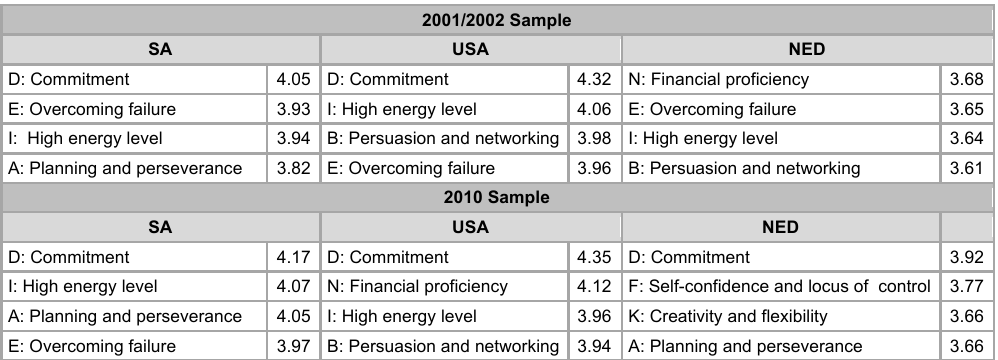
Summary of the four most developed attributes - 2001/2002 versus 2010 2001/2002